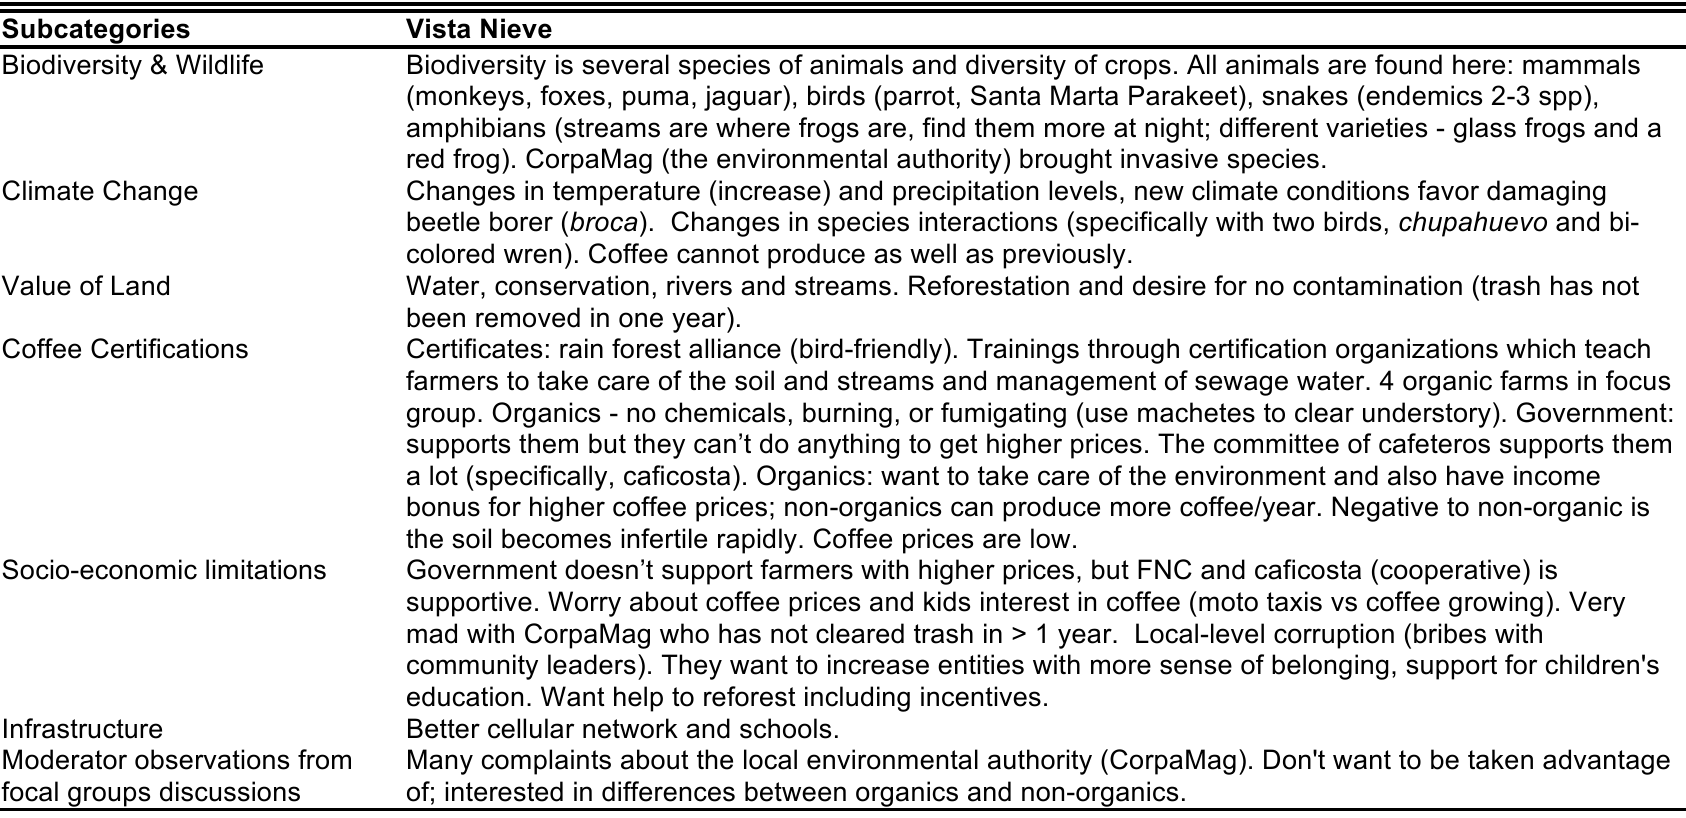
Table A2.5 The community of Vista Nieve (n=8) presented